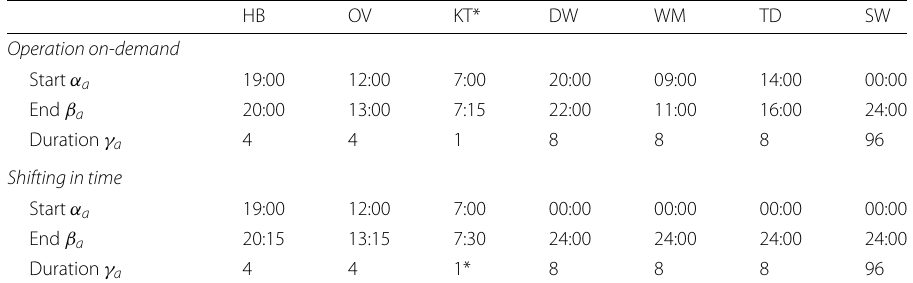
Table 3 Summary of user’s preferences